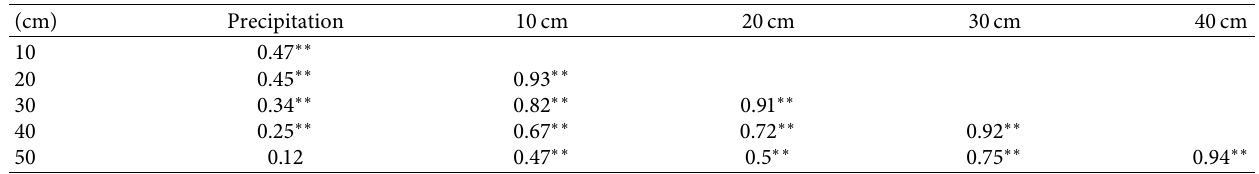
Table 4: Correlations between precipitation and SM through the soil profile at